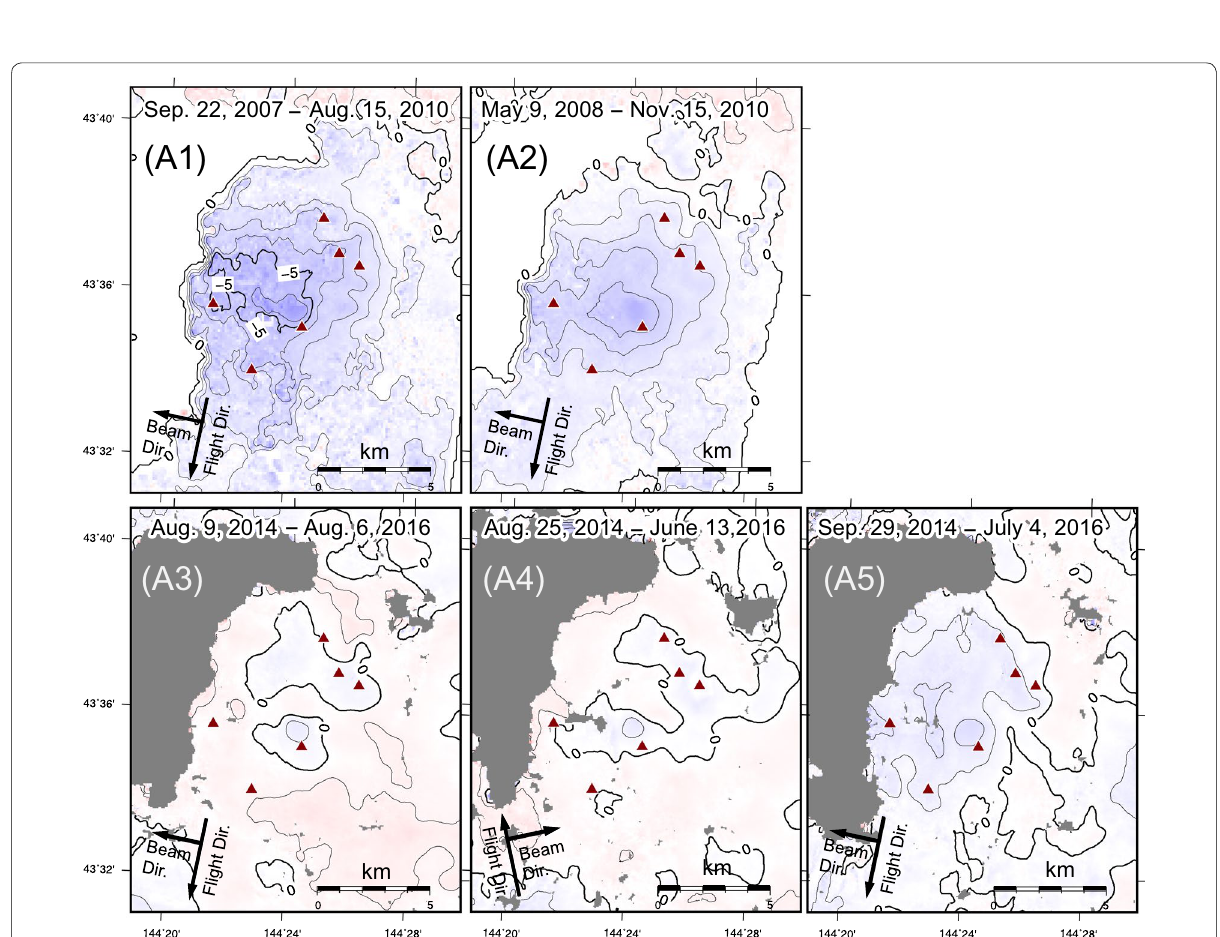
Fig. 5 Unwrapped SAR interferograms of ALOS and ALOS-2 used in this study. Each number indicates the InSAR pair in Table 1. Red triangles indicate major lava domes belonging to the Atosanupuri volcanic complex. Contour interval is 1 cm. The target area is shown in Fig.